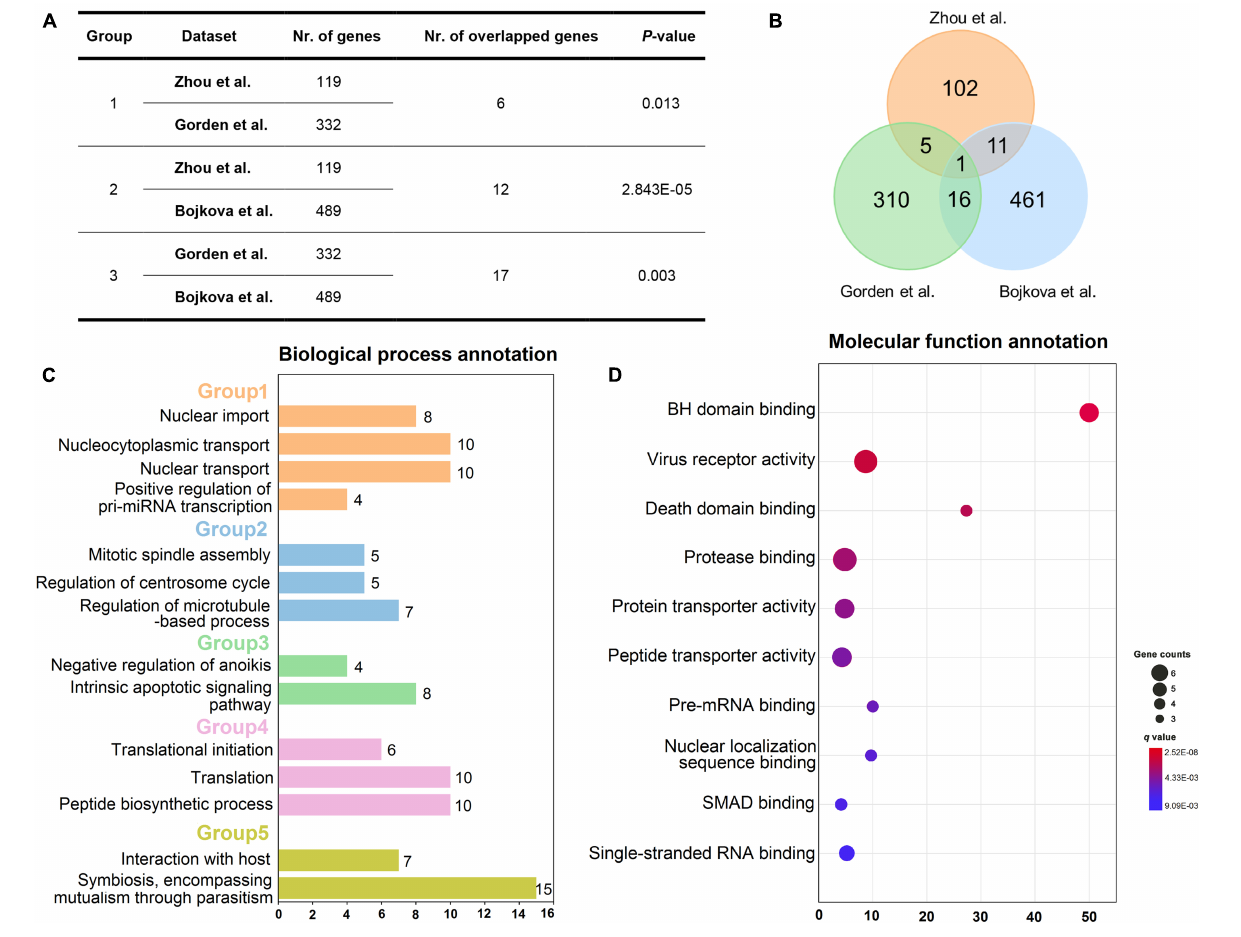
FIGURE 2 | Overview of three host gene sets and enrichment analysis of gene set from Zhou et al. Correlation analysis of three different host gene sets (A) . Venn diagram showing the number of three host gene sets as well as their overlaps (B) . Biological process annotation results of the 119 host gene set of Zhou et al. (C) . Five biological process groups are displayed in various colors. Molecular function annotation results of the 119-host gene set from Zhou et al. (D) . Note: Nr. of genes: number of genes in each host gene set; Nr. of overlapped genes: number of overlapped genes between each two host gene sets. The annotation results (C,D) were obtained via using Cluego plugin in Cytoscape software